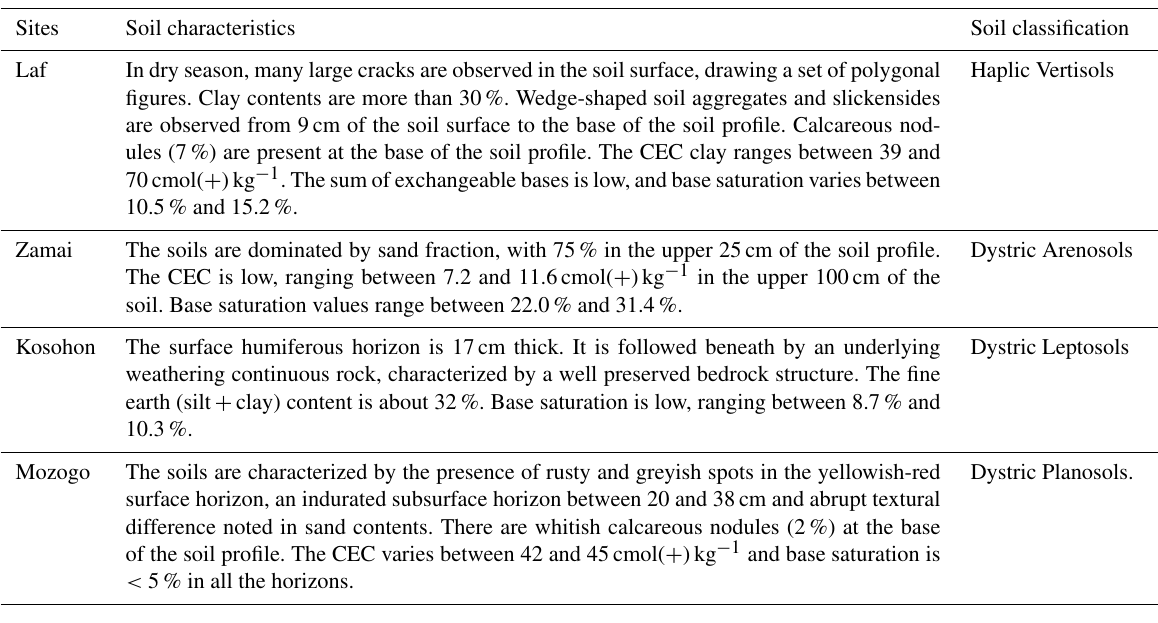
Table 2. Main soil characteristics and soil classification of the study